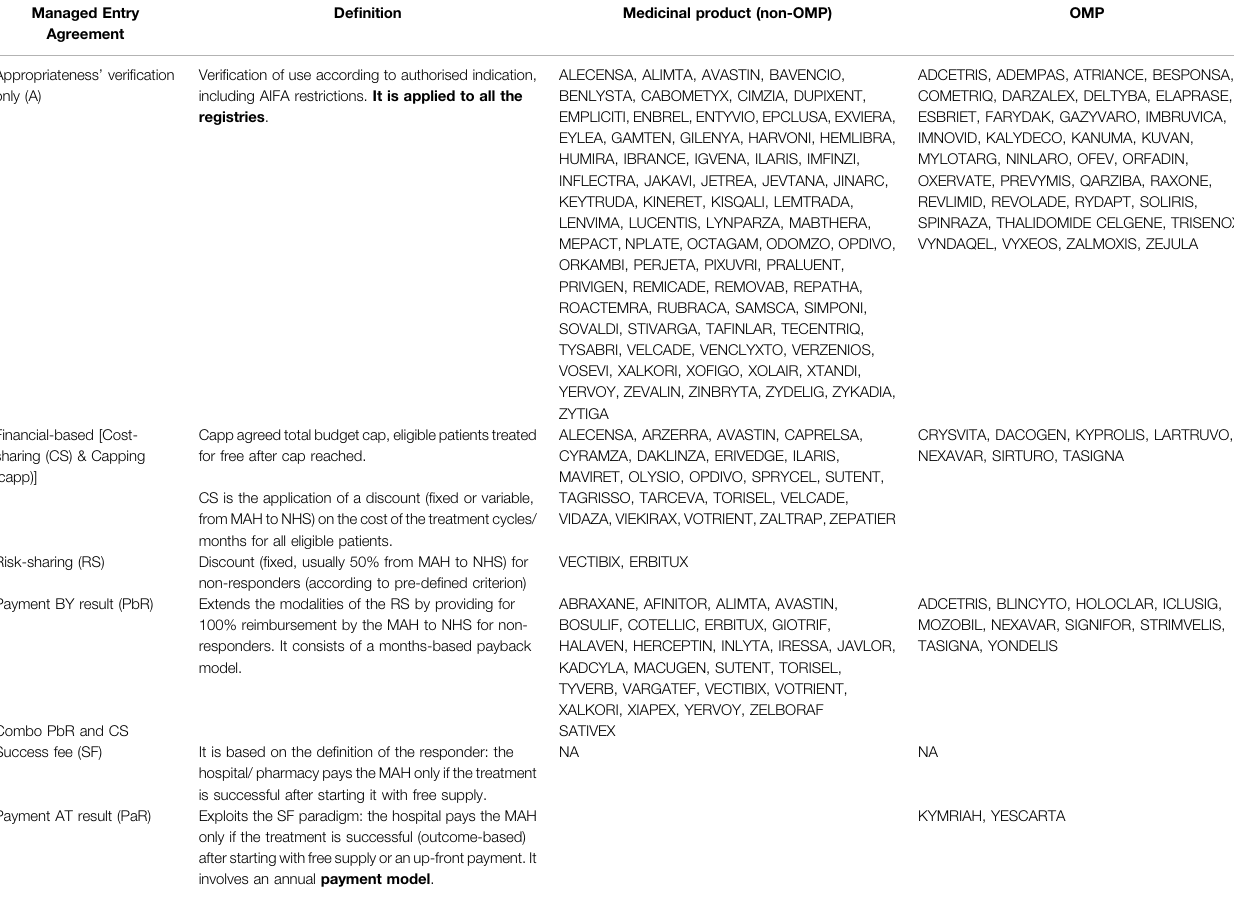
TABLE 1 | MEA classi fi cation implemented in AIFA appropriateness ’ registries (2005 – 2019). Managed Entry